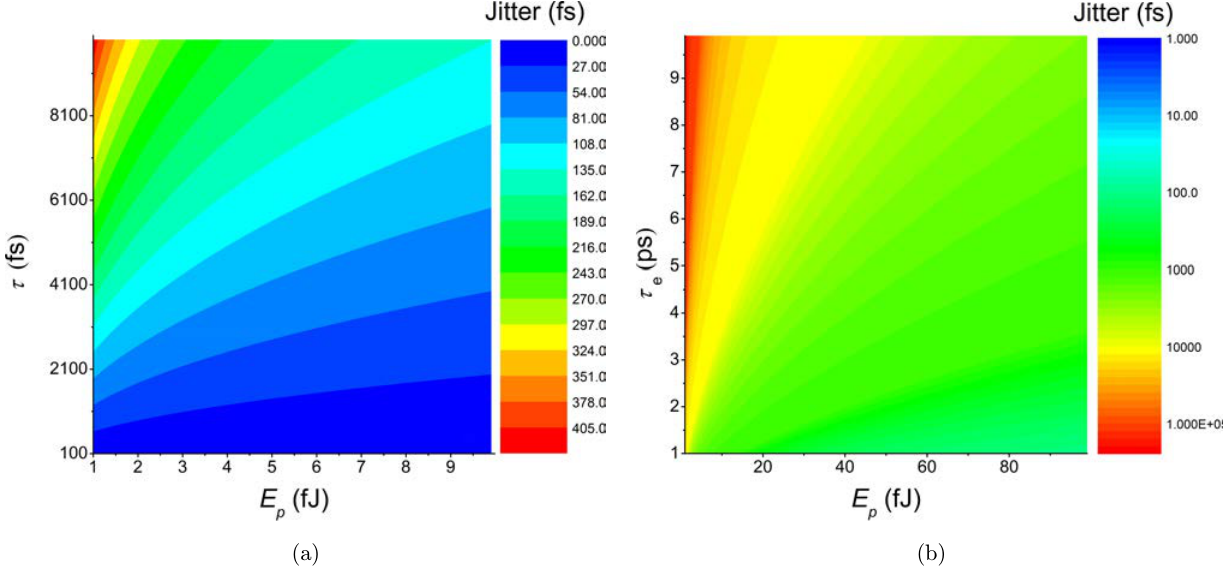
Fig. 1. Color ¯ll contour plot of the timing jitter of the electrical pulse train due to (a) shot noise and (b) thermal noise as a function of input pulse energy and pulse width. (cid:3) is the optical pulse width and (cid:3) e is the electrical pulse